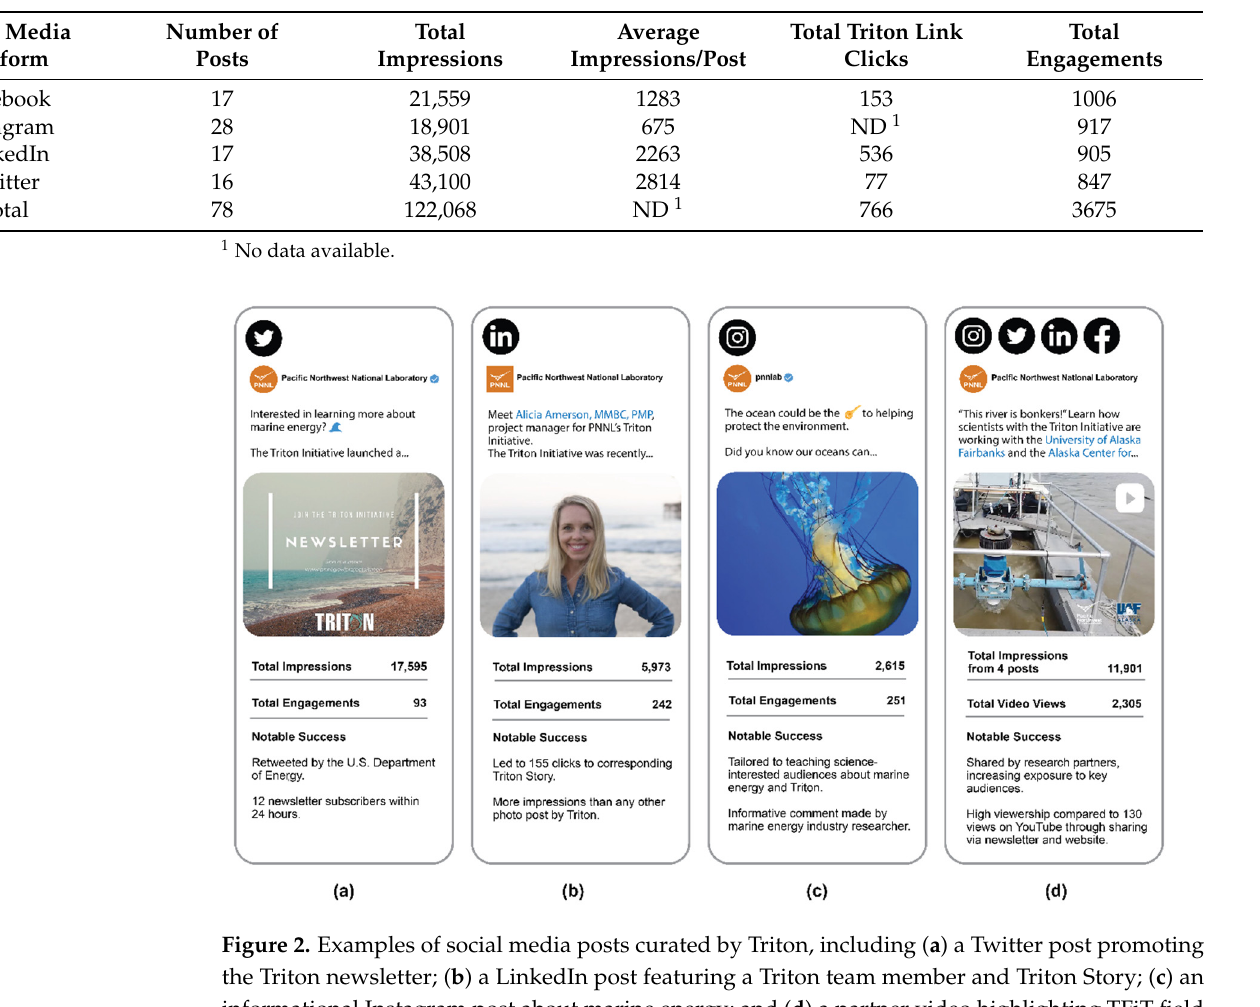
Table 2. Summary of Triton social media metrics by platform from November 2020–September 2021.